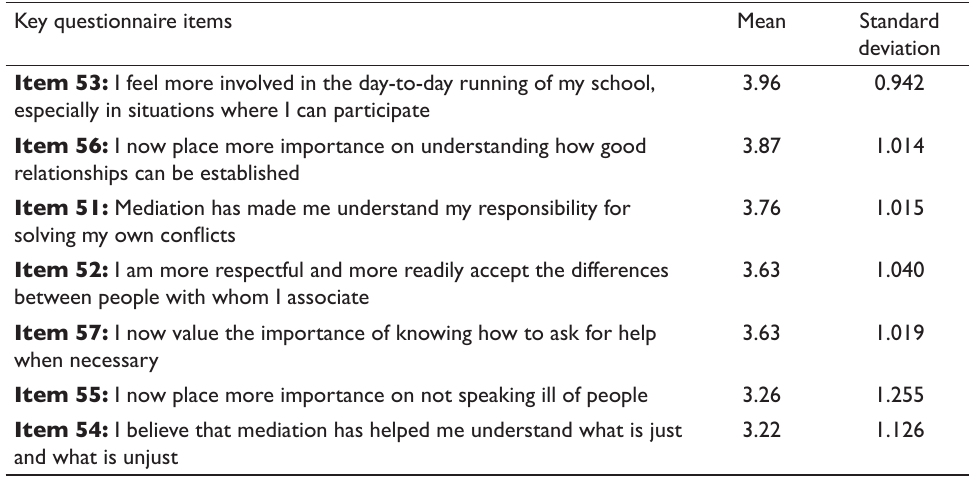
Table 3: Means and standard deviations on socio-moral aspects found among